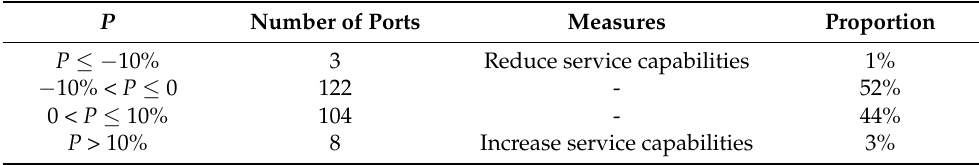
Table 5. Proportion of global container transport network reconfiguration (237